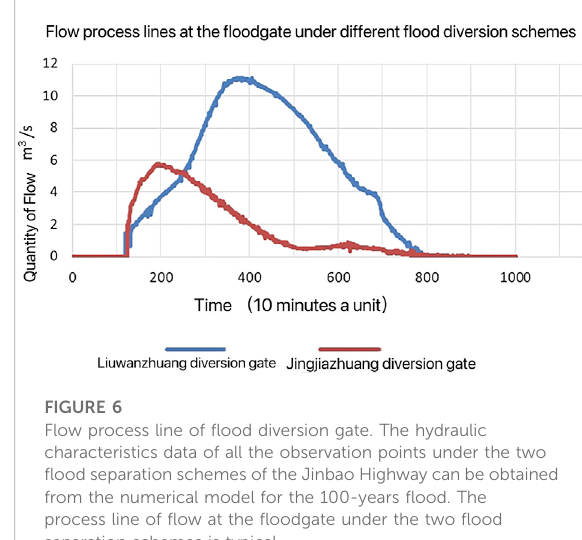
FIGURE 5 Water depth chart of the 100-years fl ood. In the fl ood storage area, simulating a super standard fl ood of100 years,the fl ood water enters the LangErwo diversion river from the Langerwo gate. It spreads to both sides when the water level exceeds the height of the diversion estuary elevation. The water spreads faster in the diversion river. It reaches the Chenzhaozhuang self-discharge gate after 48 h with an average head fl ow speed of 0.8 m/s, where the waterlevel attheChenzhaozhuangpointreaches2.87 m,andarea Ⅰ starts to fl ood areas Ⅱ and Ⅲ . The fl ood inundation depth at a particulartimenodeintheprocessof fl oodseparationwasselected .